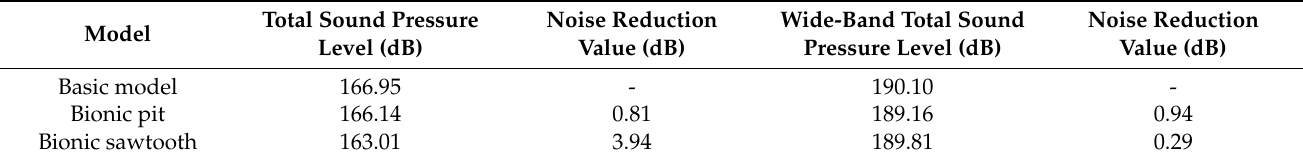
Table 3. Total sound pressure level (TOSPL) and wide-band total sound pressure level of different models under design